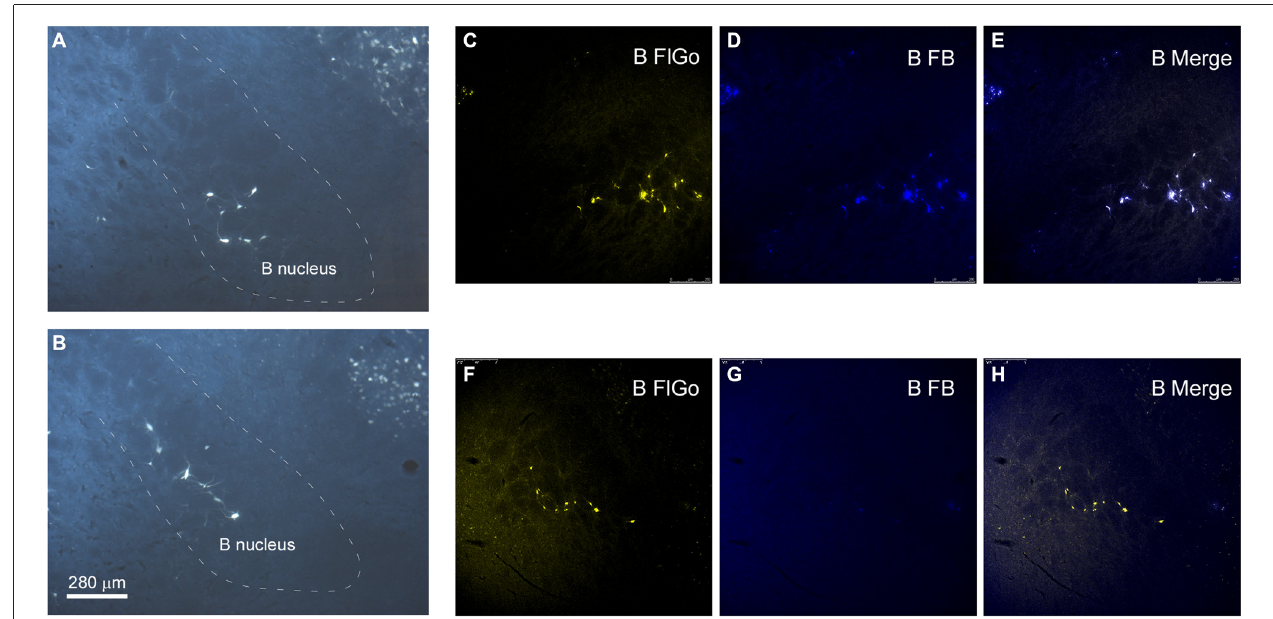
FIGURE 3 | Distribution of labeled neurons in B nucleus. (A,B) Microphotographs of coronal sections showing retrogradely-labeled neurons located in B nucleus at two different antero-posterior coordinates. Dashed lines delimitate the B nucleus. (C–H) Confocal microscope detail of FlGo (S1 injection) and FB (A1 injection) labeled neurons in B nucleus. Note that some neurons project to both cortical areas. Calibration toolbar for (A–H) 280 µ